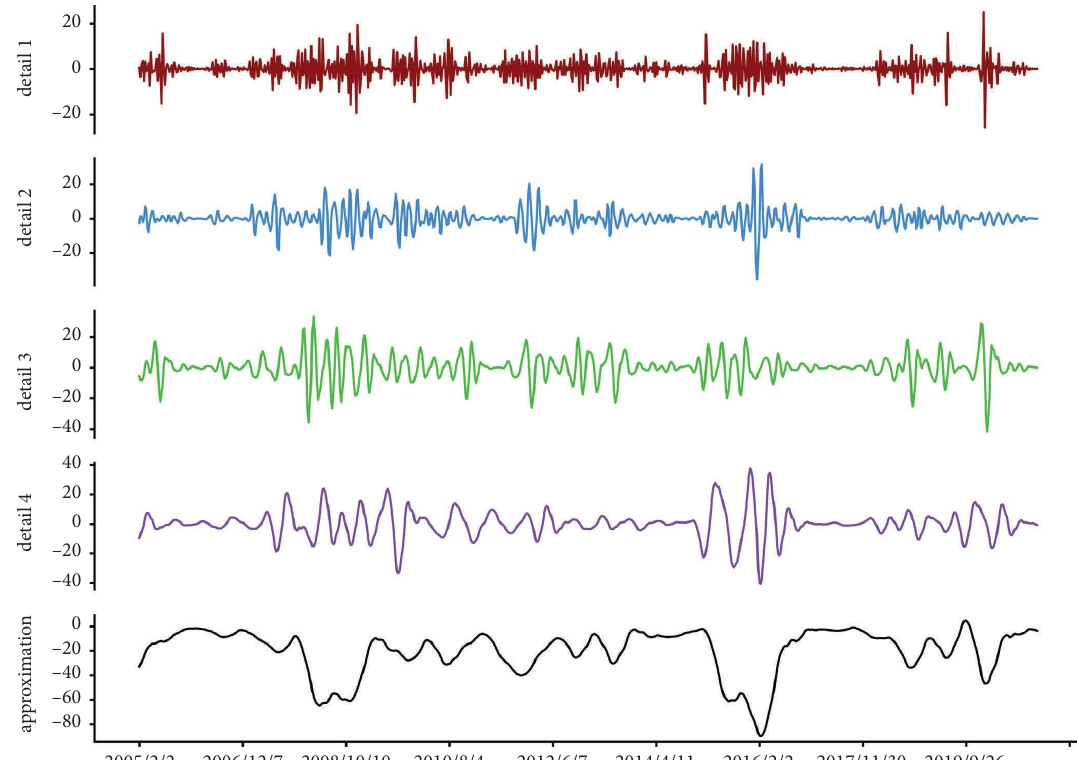
Figure 6: Te decomposition result of FR curvature series.